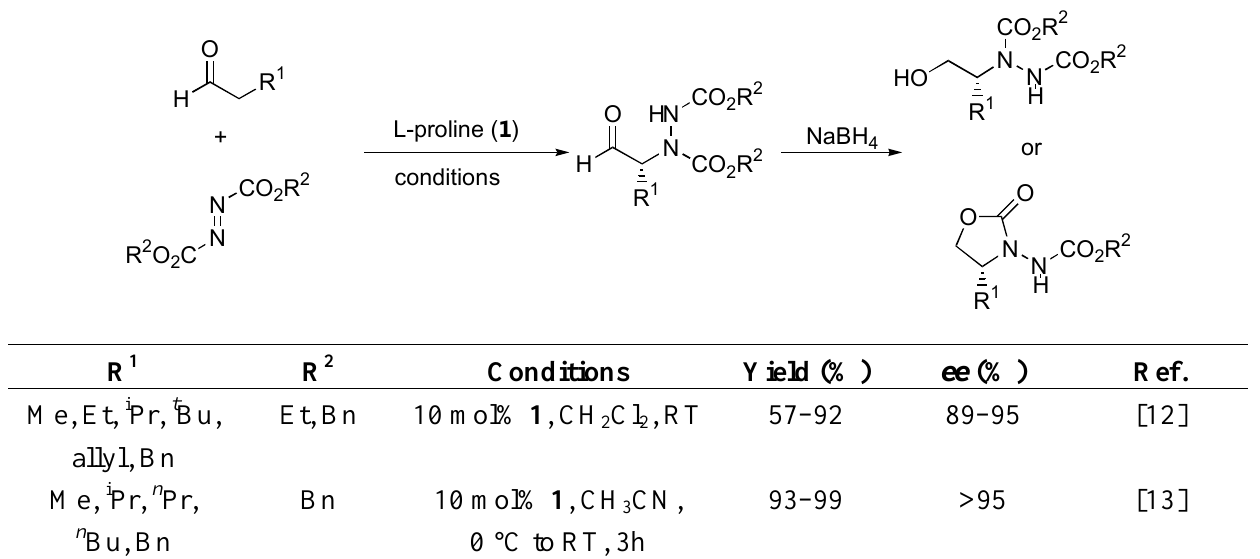
Table 1. Proline catalyzed  -amination of unbranched